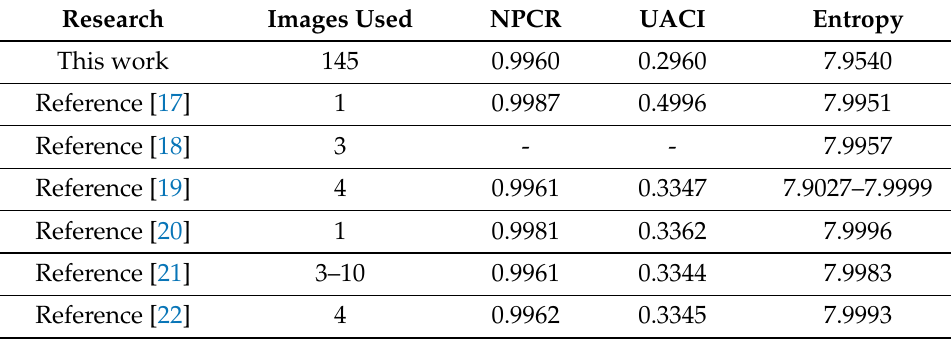
Table 5. Performance comparison with other related